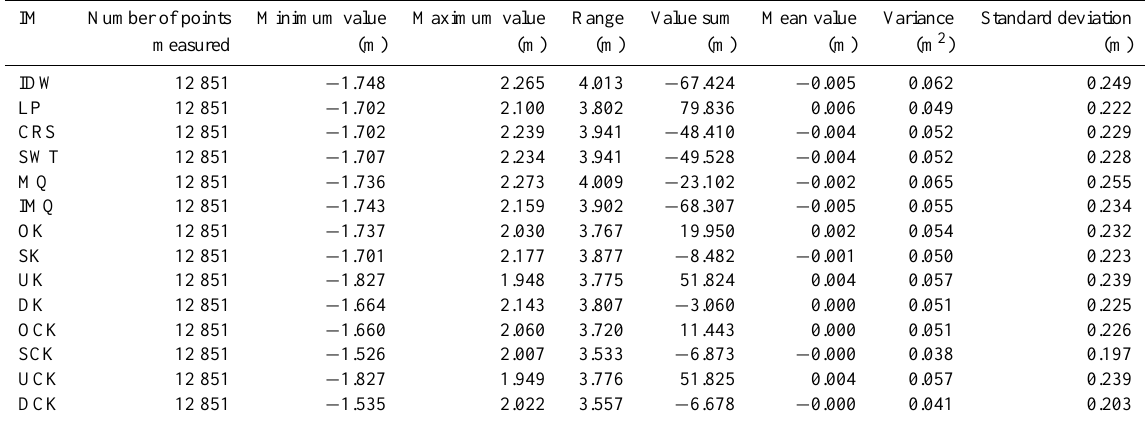
Table 2. Cross-validation results calculated only on point data gathered by bathymetric measurement.